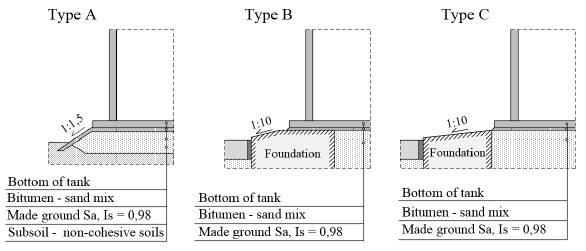
Figure 1: Analyzed types of tank foundations: Type A, Type B, Type C.